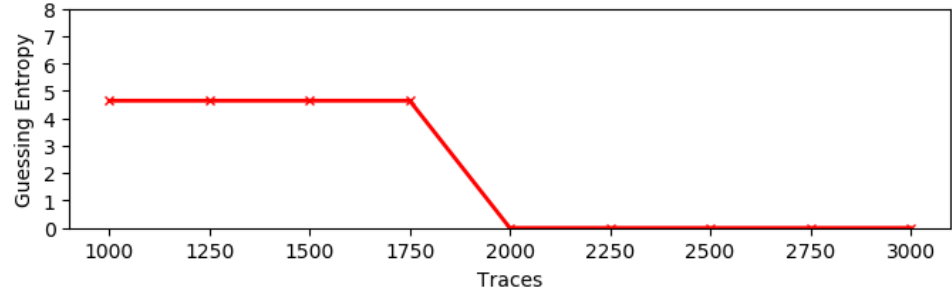
Figure 7: Evolution of the guessing entropy of the second key byte for different number of traces.